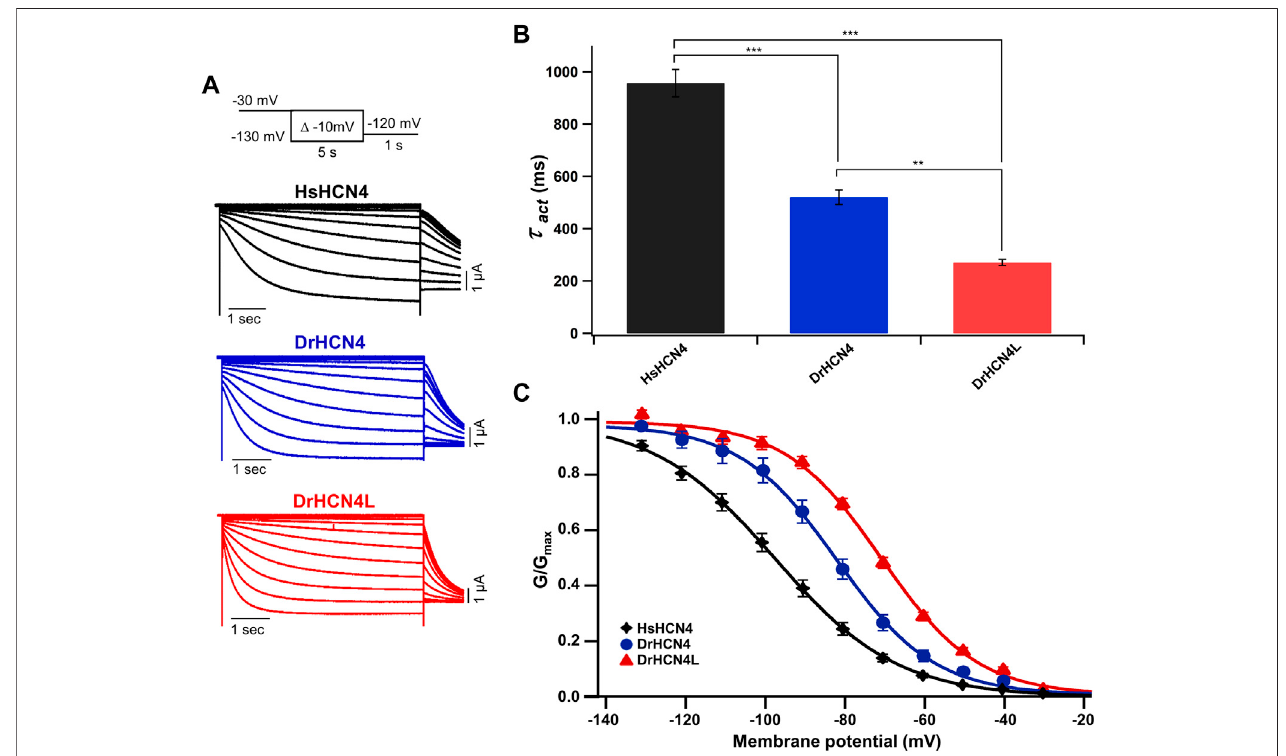
FIGURE1| Zebra fi shHCN4 channelsarehyperpolarization-activated ionchannels. (A) Representative currentsofthehuman HCN4 channelHsHCN4 (black)and zebra fi shHCN4channelsDrHCN4(blue)andDrHCN4L(red).Theholdingpotentialwassteppedfrom − 30 mVto − 130 mVin10-mVdecrementsandheldfor5 sateach potential. The inset shows the stimulation protocol. (B) Time constants obtained by fi tting the activating currents of HsHCN4 (black), DrHCN4 (red) and DrHCN4L (blue) at − 130 mV. (C) Activation curves (G – V curves) of human and zebra fi sh HCN4 channels ( n = 5 for each).